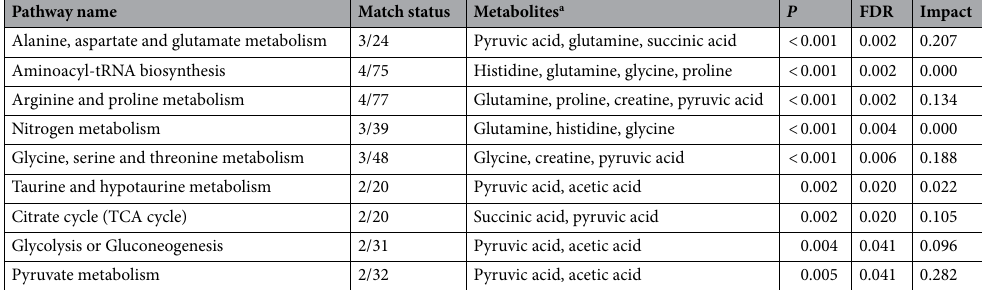
Table 3. Functional pathway analysis of metabolites associated with MDD with full remission. MDD major depressive disorder, FDR false discovery rate, TCA tricarboxylic acid. a Metabolites for which p < 0.05 were selected.